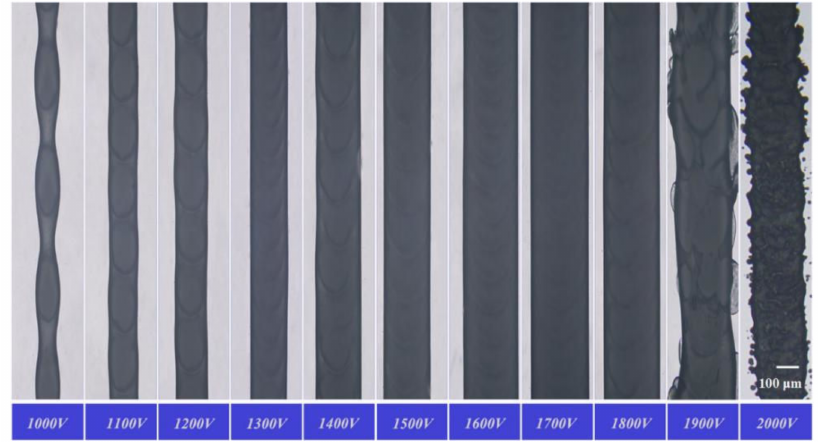
Figure 5. Photos of the printed wax lines with di ff erent working